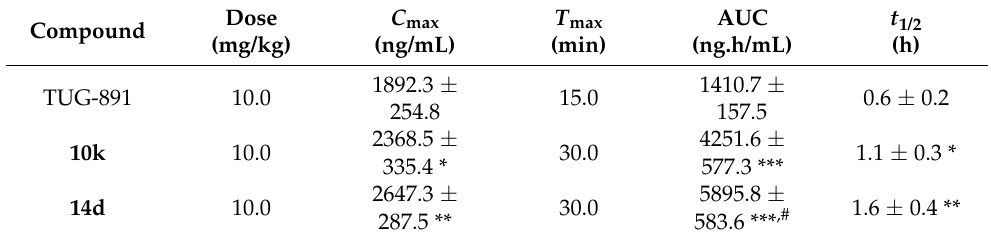
Table 4. Pharmacokinetic profiles of compounds 10k and 14d in C57BL/6 mice a .